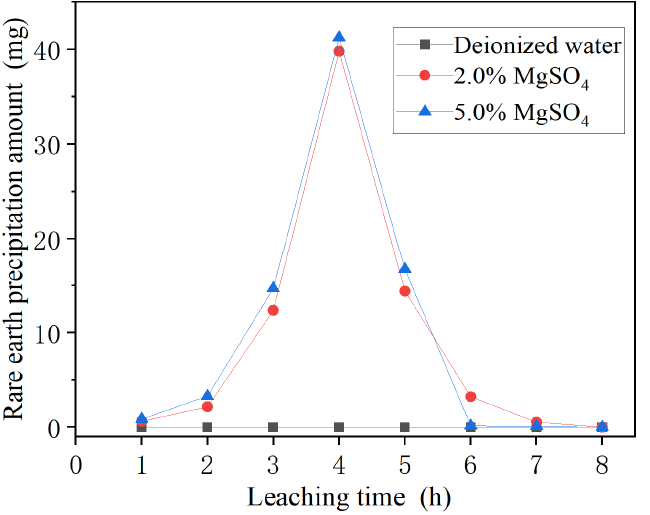
Figure 3. Variation of RE precipitation in different concentrations of MgSO 4 and DI water leaching solution with leaching time.